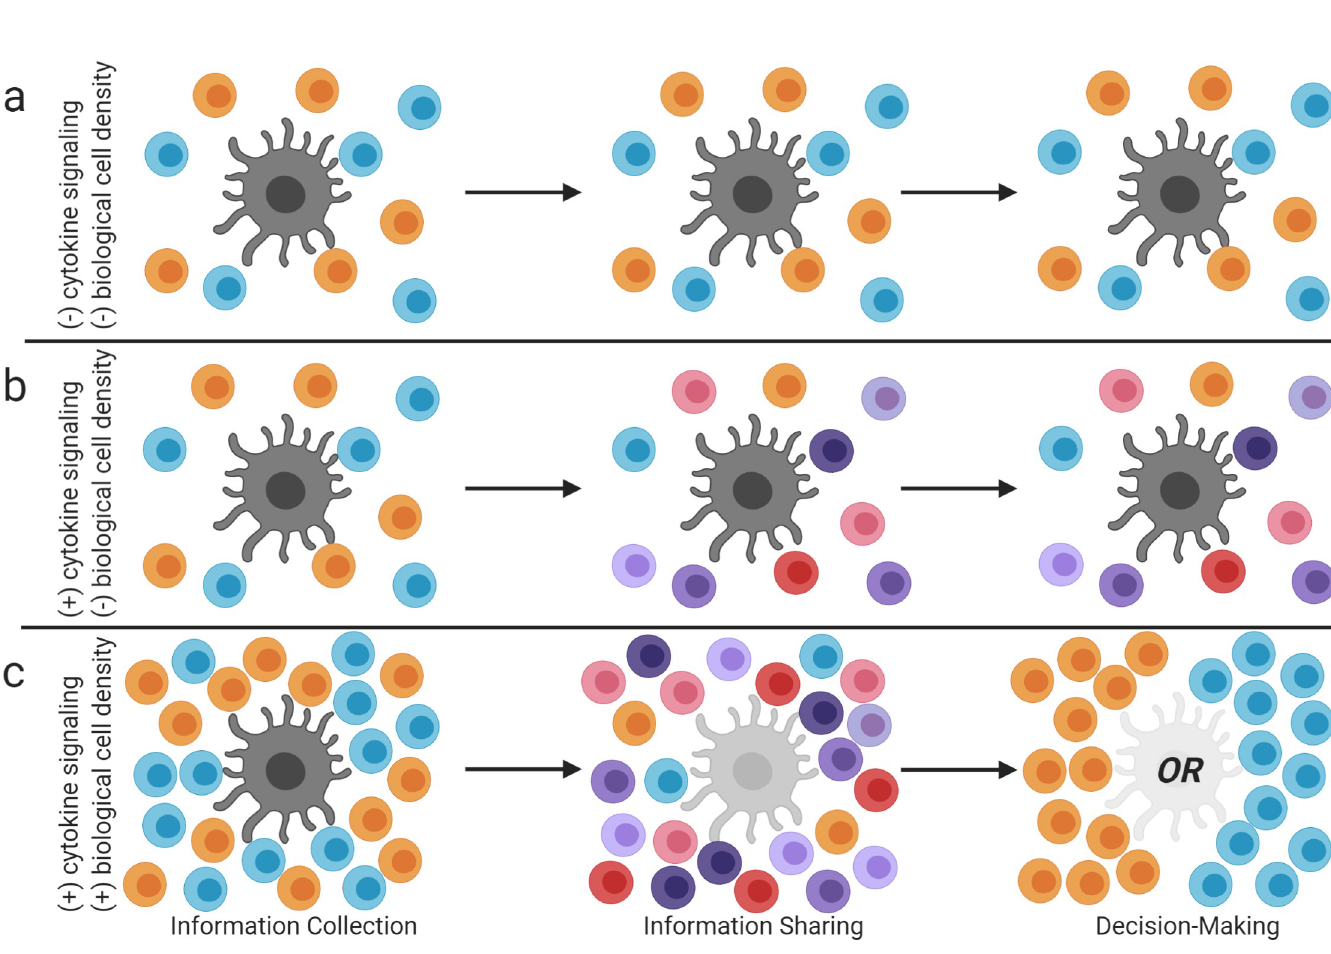
Fig 7. Cartoon of major conclusions. Orange circles represent Th1 cells, blue circles represent Th2 cells, and other shades represent Th1-Th2 hybrid cells. The large gray shapes represent APCs, or experimentally provided effector stimulation. (a) At 10 6 cells/mL with no dynamic cytokine signaling, individual neighboring Th cells adopt oppositely polarized effector types. (b) At 10 6 cells/mL with dynamic cytokine signaling, oppositely polarized Th cells cause each other to become Th1-Th2 hybrids. (c) At 10 9 cells/mL with dynamic cytokine signaling, mixed effector types resolve into fully polarized Th1 or Th2 groups, via quorum sensing. Initial polarization by APCs, effector hybrid formation as cytokines dynamically accumulate, and quorum emergence as cytokines accumulate further and APCs are ignored, may define 3 phases of Th effector differentiation in vivo .